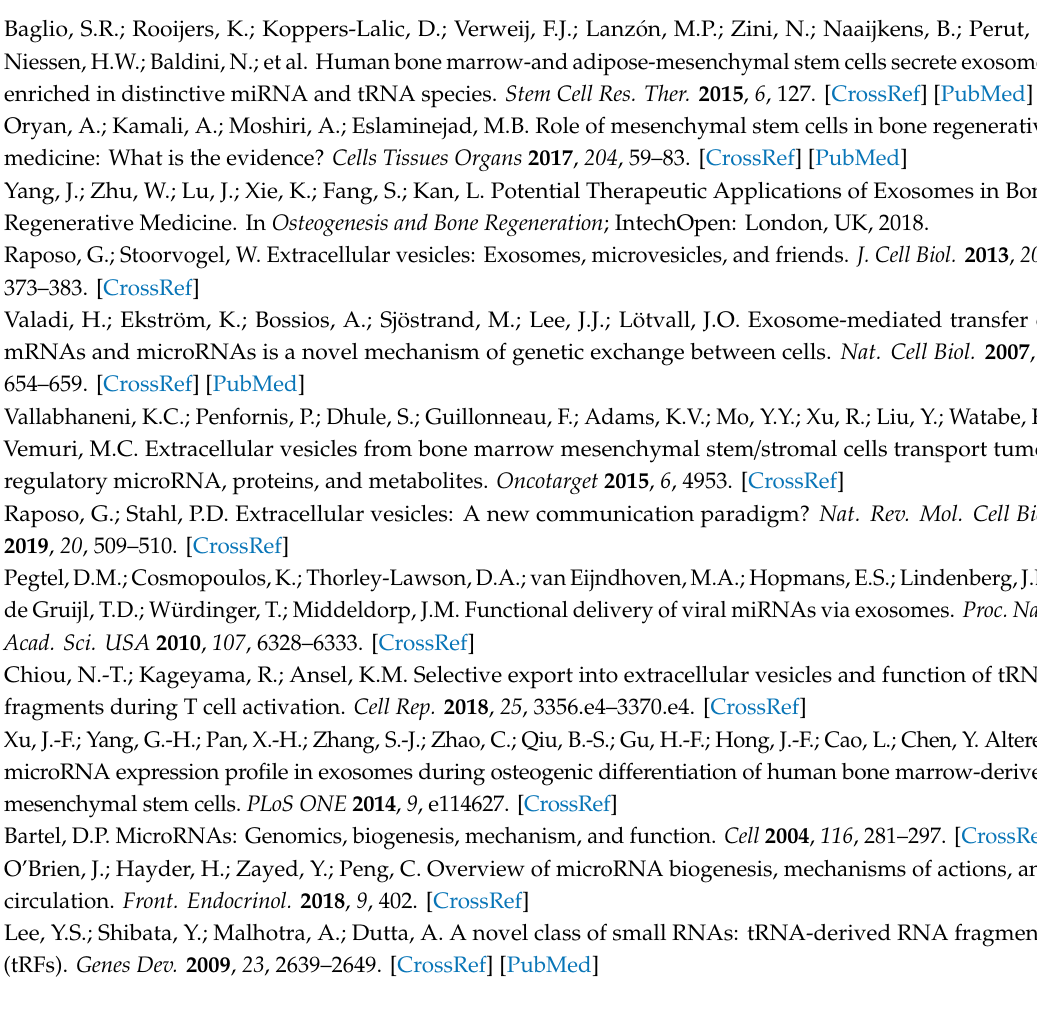
Figure S1: QPCR quantification of gene expression of osteoblastic di ff erentiation markers in BMSCs, Table S1: The characteristics of cell